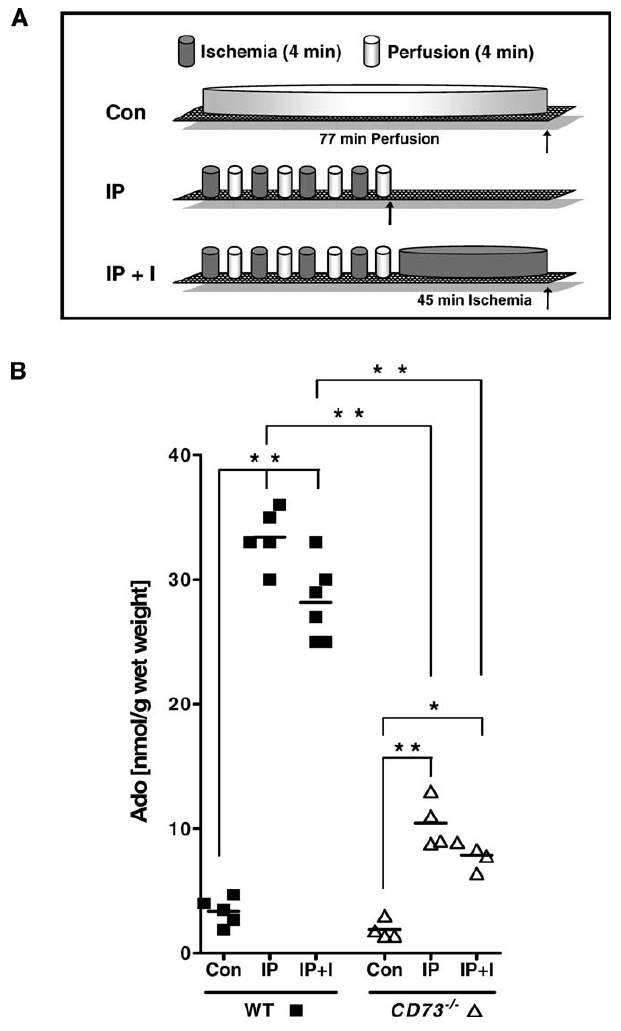
Figure 1. Renal Adenosine Tissue Content with IP Treatment with or without Subsequent Ischemia Age-, gender-, and weight-matched cd73 (cid:2) / (cid:2) mice or littermate controls (WT) were subjected to IP alone (IP) or IP followed by 45 min of ischemia (IP þ I) using a hanging weight system for atraumatic occlusion of the left renal artery. The IP protocol consisted of four cycles of ischemia and reperfusion (4 min each). Statistics: One-way ANOVA was used to perform comparisons among groups. The F -test results are F (5,22) ¼ 210.34, p , 0.001. All statistically significant differences within groups were compared by Tukey’s post-hoc test ( p , 0.05) and were indicated with a bracket (*, p , 0.01; **, p ,